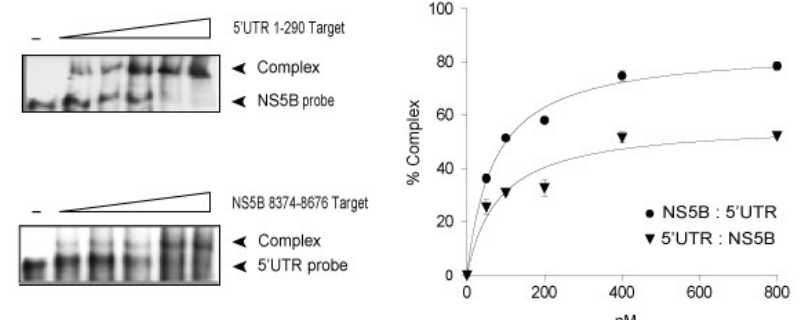
Figure 2. In vitro complex between 5 (cid:48) UTR nt 1–290 and NS5B nt 8374–8676 RNAs. 32 P-labeled RNA probe (20 nM) was incubated with increased amounts of unlabeled RNA target (50–800 nM) in low magnesium binding buffer. Complexes were separated in a native 5% acrylamide gel buffered with TBM. Plots of % probe complex versus target concentration ± SE were derived from three separate experiments. See Materials and Methods Section 2.5 RNA Binding Assays for derivation of K d and B max